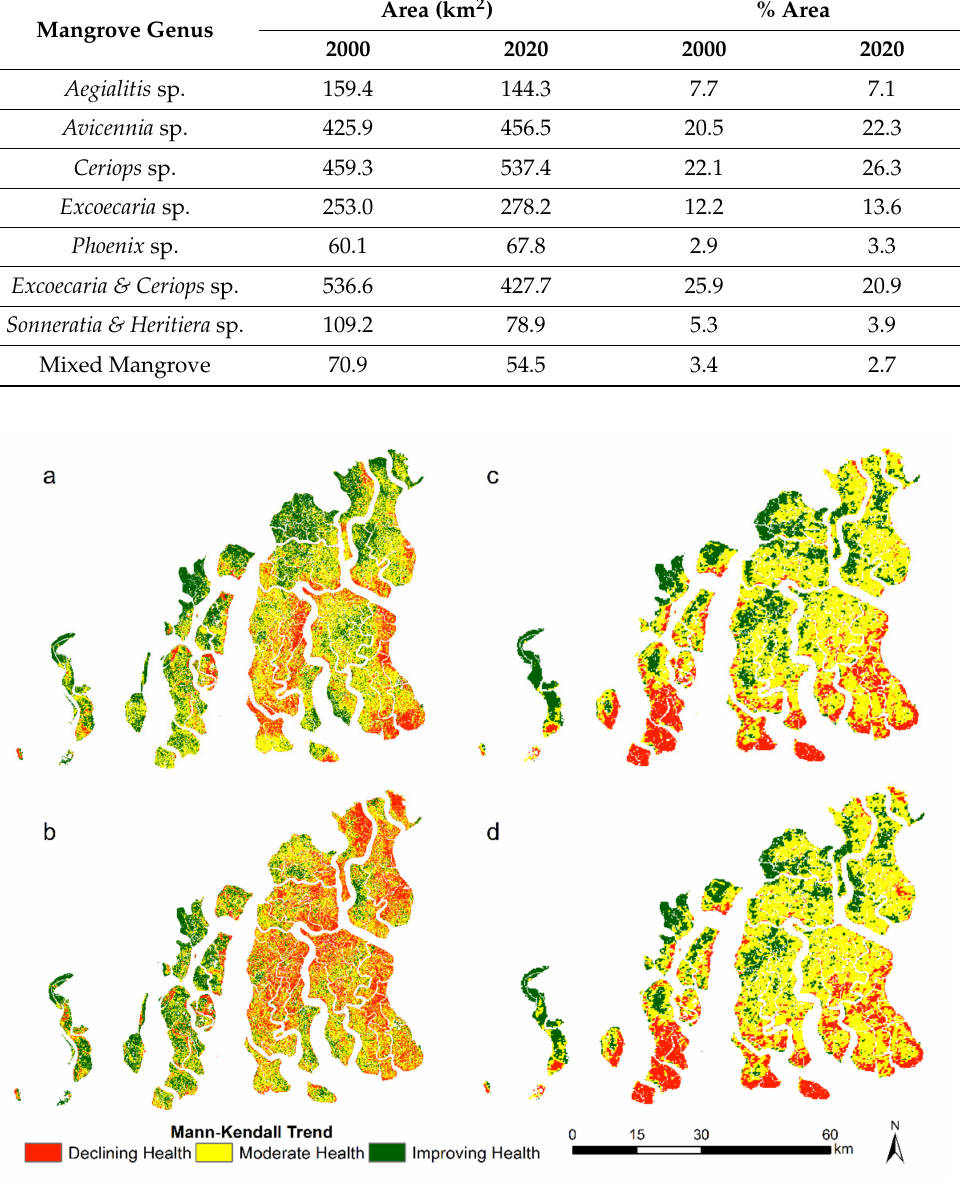
Figure 4. Trends in vegetation indices in terms of improving health and declining health from 2000 to 2020 using the Mann–Kendall test on EVI and NDVI, derived from Landsat and Modis data (( a )—Landsat NDVI MK test; ( b )—Landsat EVI MK test; ( c )—MODIS NDVI MK test; ( d )—MODIS EVI MK